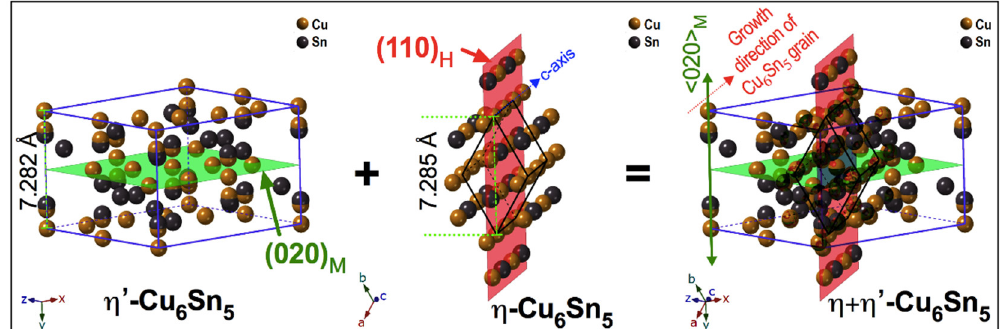
Figure 6. The monoclinic and hexagonal structures simulated by Single Crystal software showing the (020) M and (110) H planes, respectively.